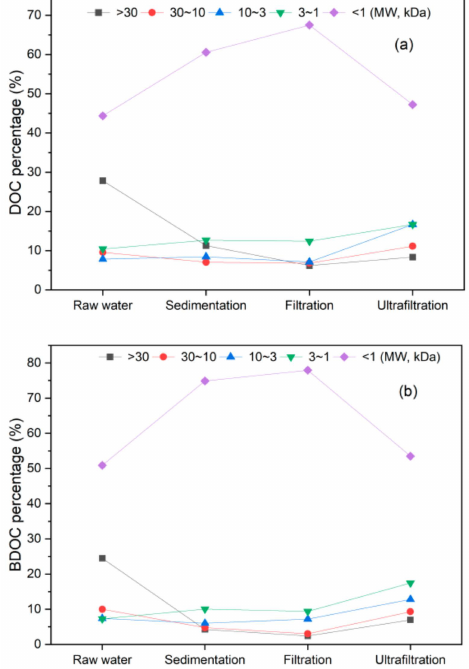
Figure 3. MW distribution of DOC and BDOC in waterworks. ( a ) DOC; ( b )